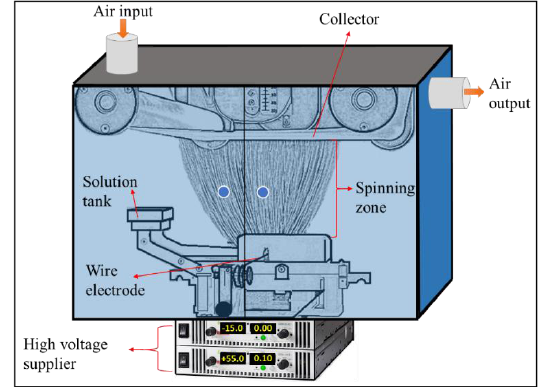
Figure 1. Schematic diagram of the Nanospider device.